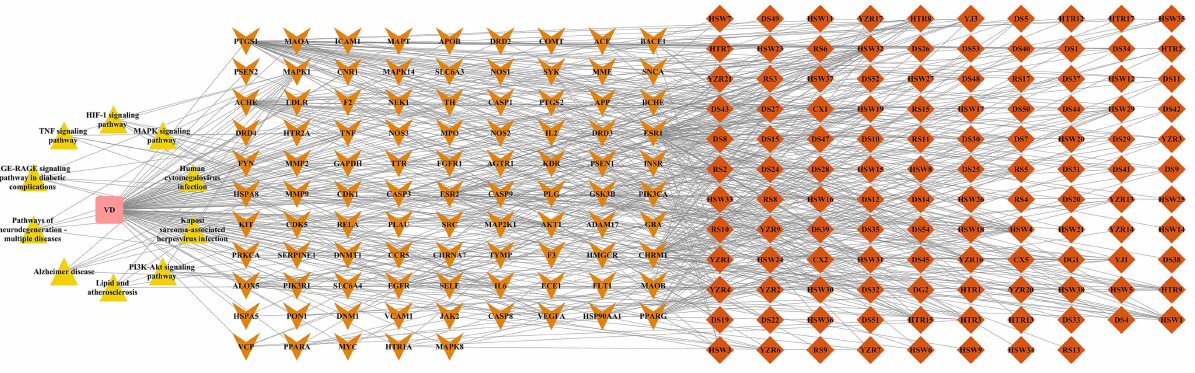
Fig. 5. Herb-pathway-targets network. The diamond represents the compound target of the drug, the triangle represents the pathway, and the arrowhead represents the disease target.